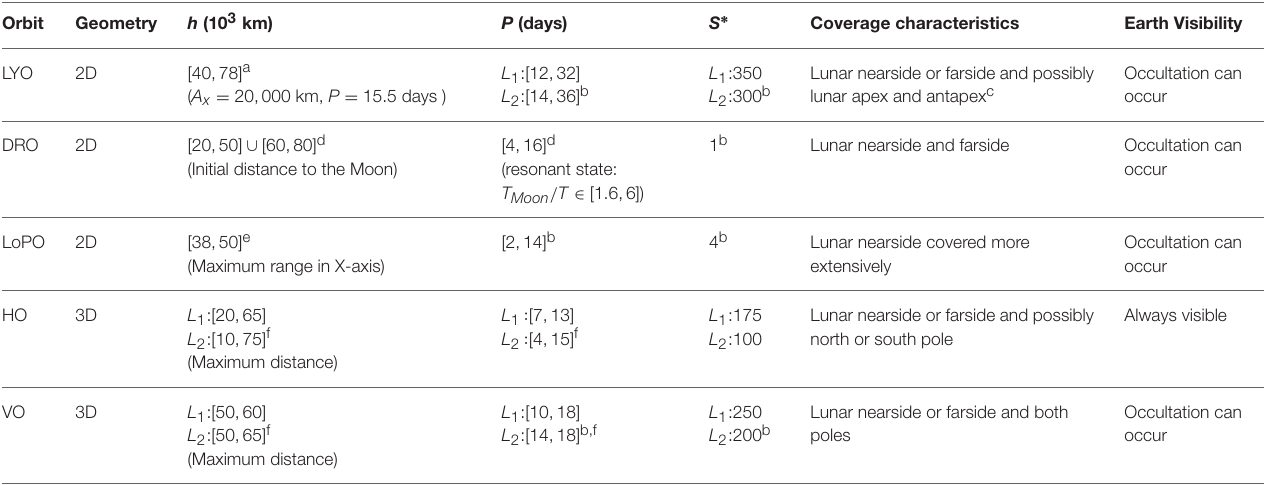
TABLE 3 | Characteristics of libration point lunar remote sensing